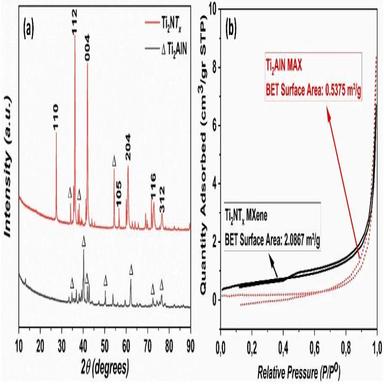
(a) XRD patterns, and (b) BET surface area adsorption results of Ti2AlN MAX and Ti2NTx MXene phases.